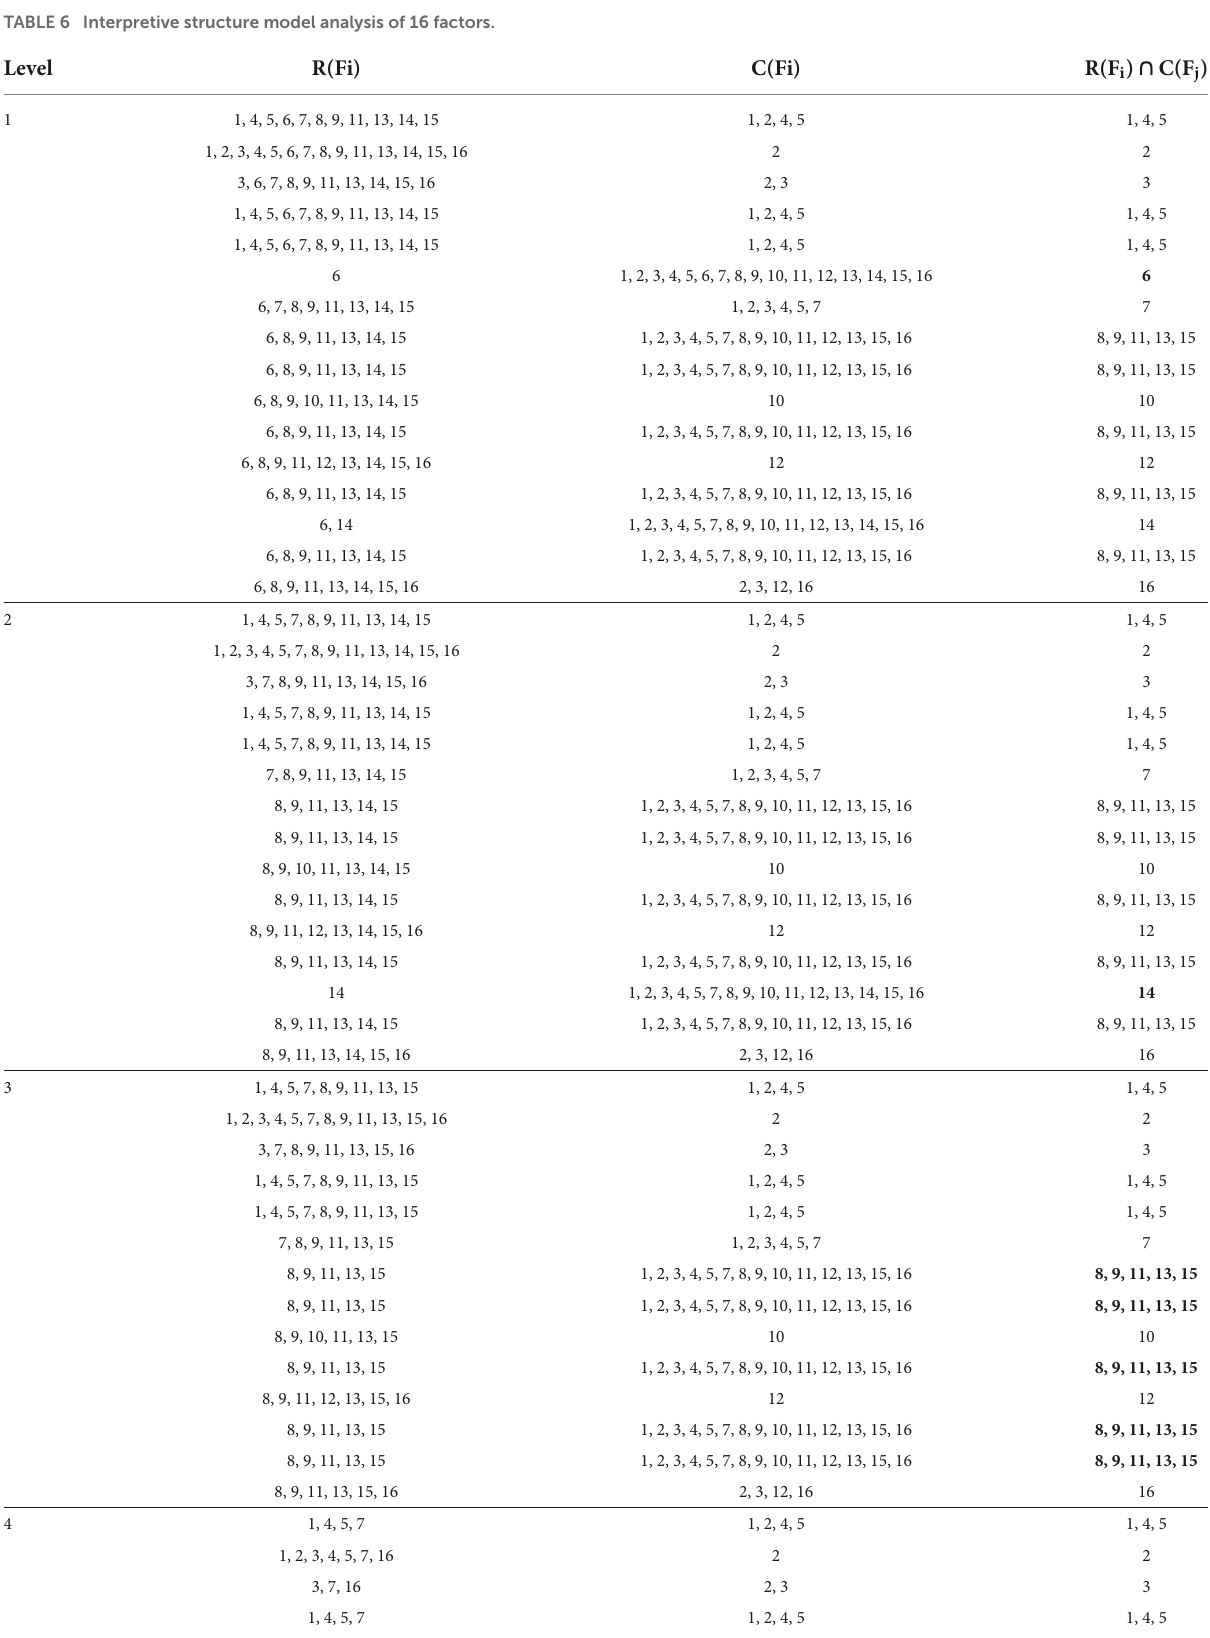
TABLE 6 Interpretive structure model analysis of 16